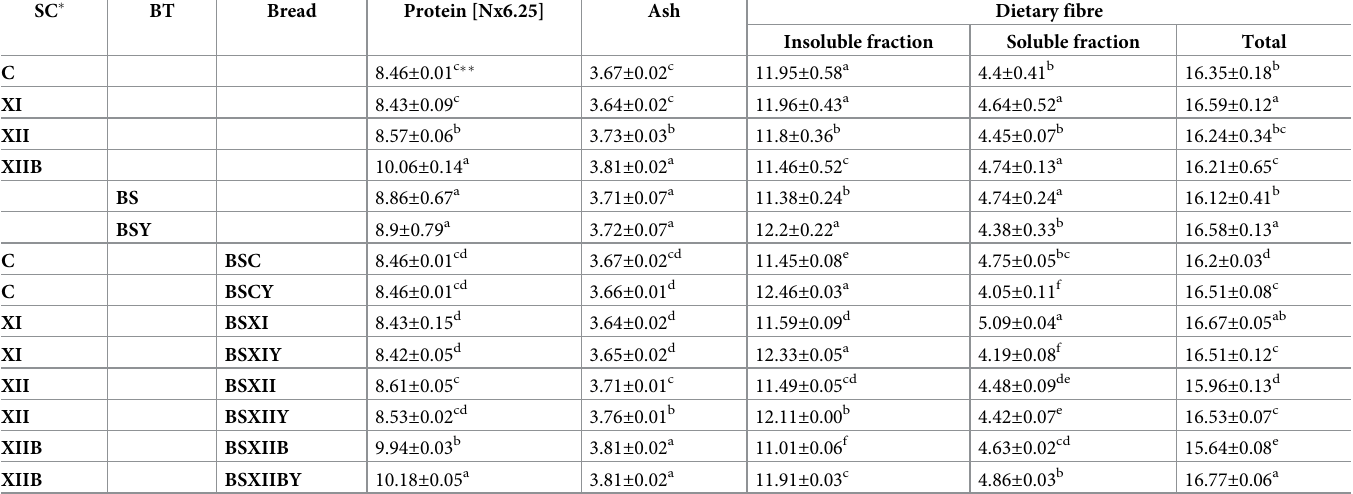
Table 5. Basic composition of the investigated breads [g 100g -1 db].